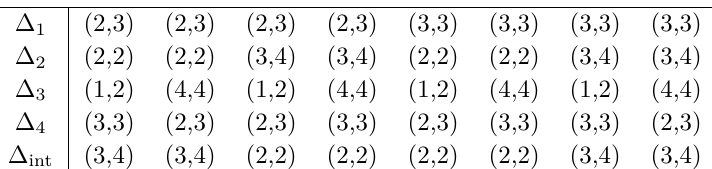
Table 10. There are 8 possible combinations. Each column gives a CB. In the leftmost column, ∆ i ’s follow the nomenclature correpsonding to (3.36). For (3.37), it just swaps 2 ↔ 3 (and ∆ Therefore, it essentially gives the same CBs. In other words, the two solutions just correspond to reading the 4-point CB (3.32) from left or from